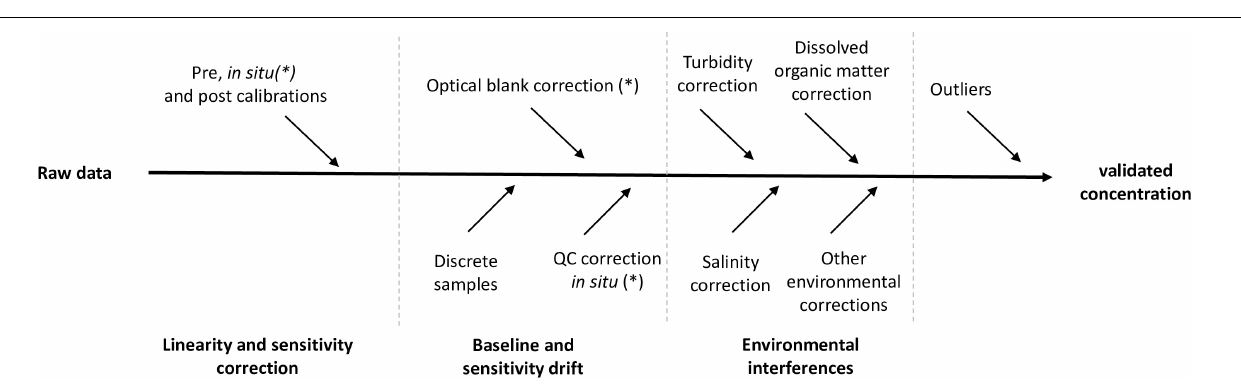
FIGURE 3 | Uncertainty estimation approaches (from EUROLAB, 2007).